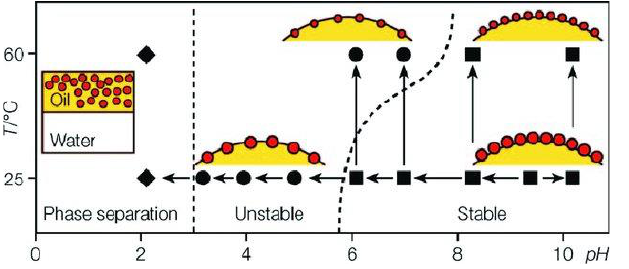
Figure 6. Stabilizing efficiency of PNIPAM microgel particles for oil-in-water Pickering emulsions as a function of pH and temperature. ( ■ ) Stable emulsions, (●) unstable emulsions and ( ▲ ) phase separation. Reproduced from Ngai et al. [84] with permission from the Royal Society of Chemistry, Copyright (2005).